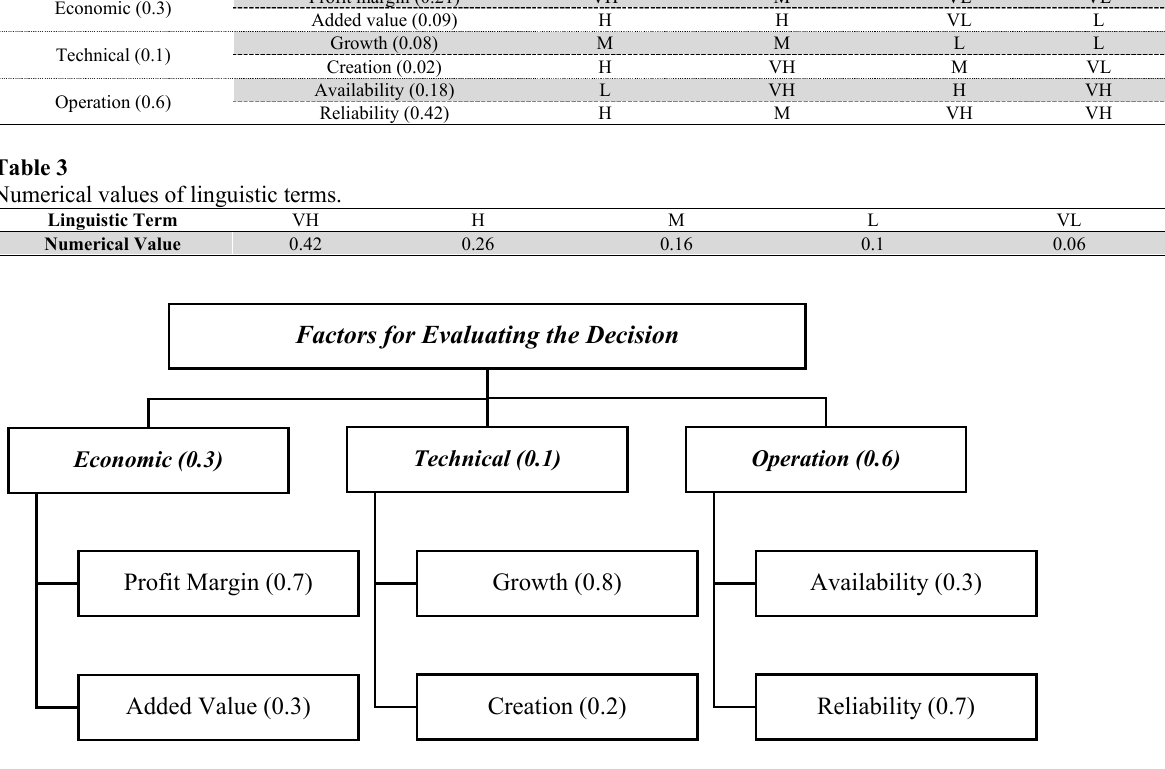
Fig. 2. Three main decision